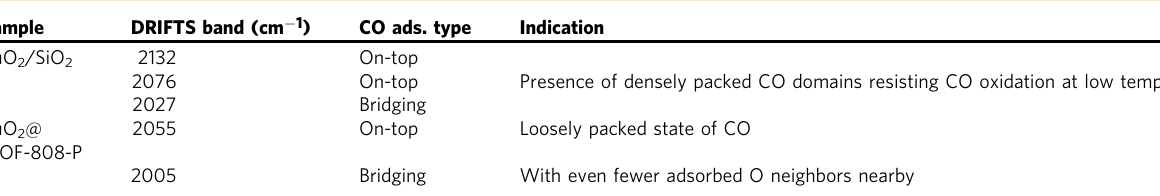
Table 1 Diffuse re fl ectance infrared Fourier transform spectroscopy (DRIFTS) absorption bands for RuO 2 /SiO 2 and RuO 2 @MOF- 808-P and their indications 40,56